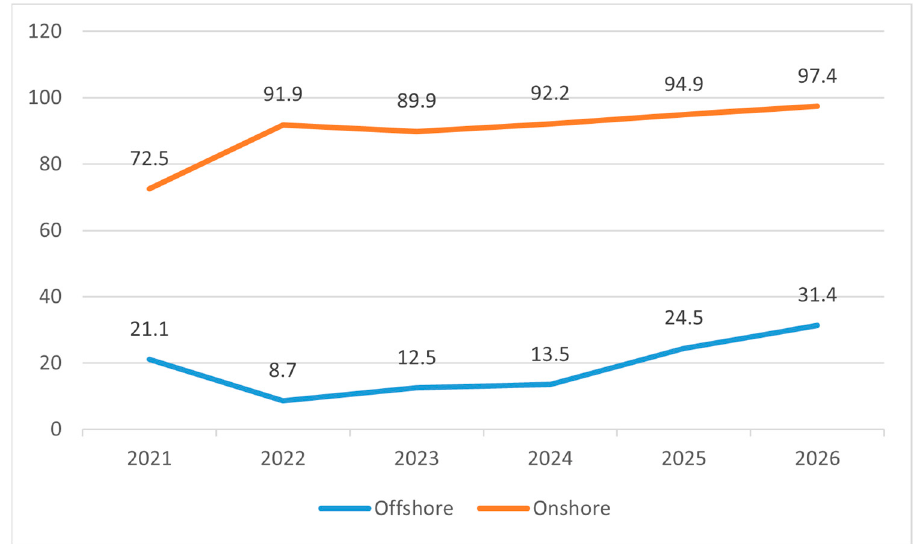
Figure 2. New wind power installations outlook for 2022–2026